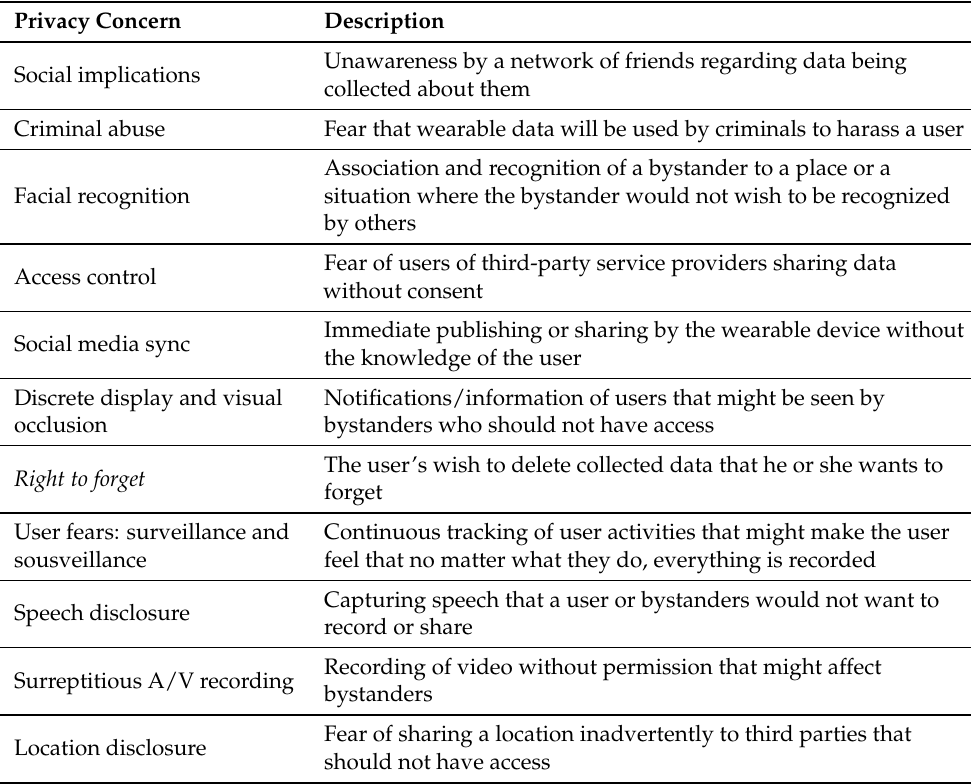
Table 6. Wearable user’s privacy concerns, as researched by the authors of